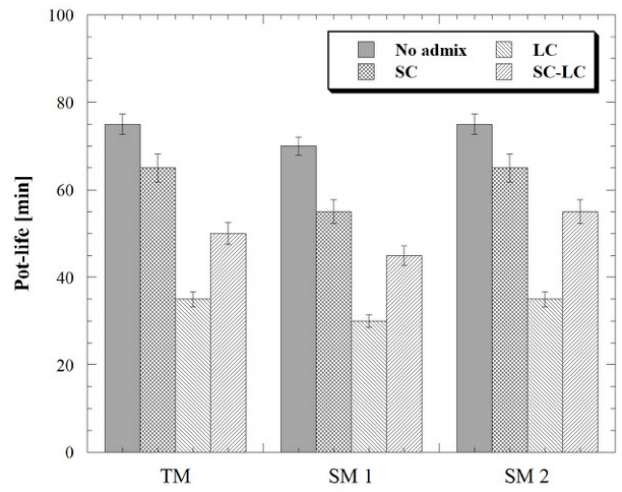
Figure 2. Pot-life of fresh mixtures.